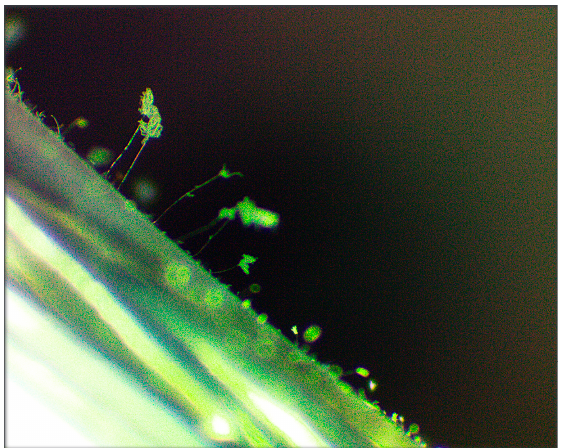
Figure 2. Sporulation of test-culture Paecilomyces variotii VKM F-378 on the surface of the testing specimen of polyethylene film coating.